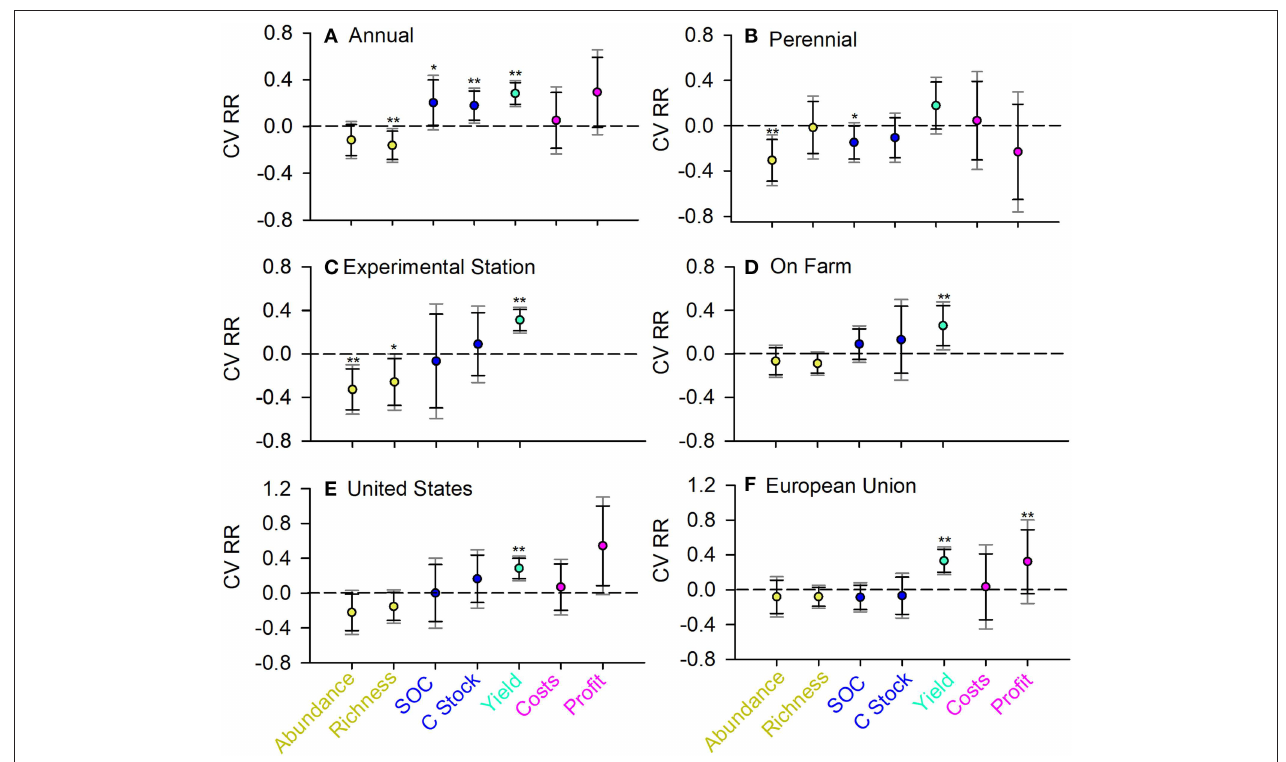
FIGURE 5 | Response ratio for coefficient of variation of sustainability ( ± 90% CI black; 95% CI gray) for (A) annual crop types, (B) perennial crop types, (C) on experimental stations, (D) on farms, (E) studies in the United States, and (F) studies in the European Union. *Indicates 90% CI did not overlap 0; **indicates 95% CI did not overlap